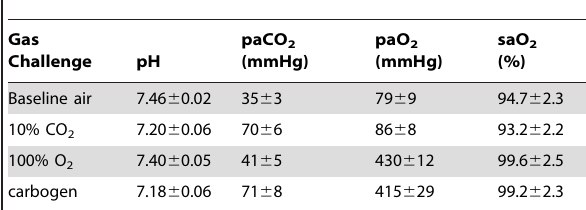
Table 1. Arterial blood gas